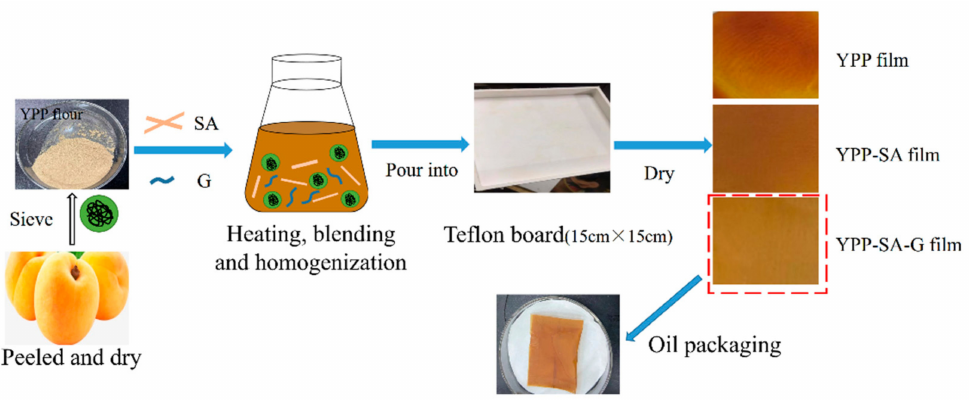
Figure 1. The schematic of the film-forming